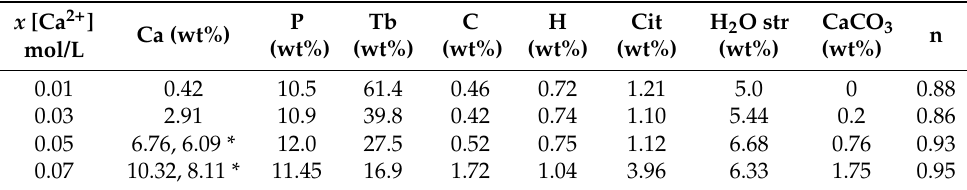
Table 1. Quantitative analyses of Ca, P, Tb, C, H, and estimated percent weights of structural citrate, H 2 O, CaCO 3 and hydration number n of the samples prepared with Ca 2+ doping concentration x ranging from 0.01 to 0.07 M, at 96